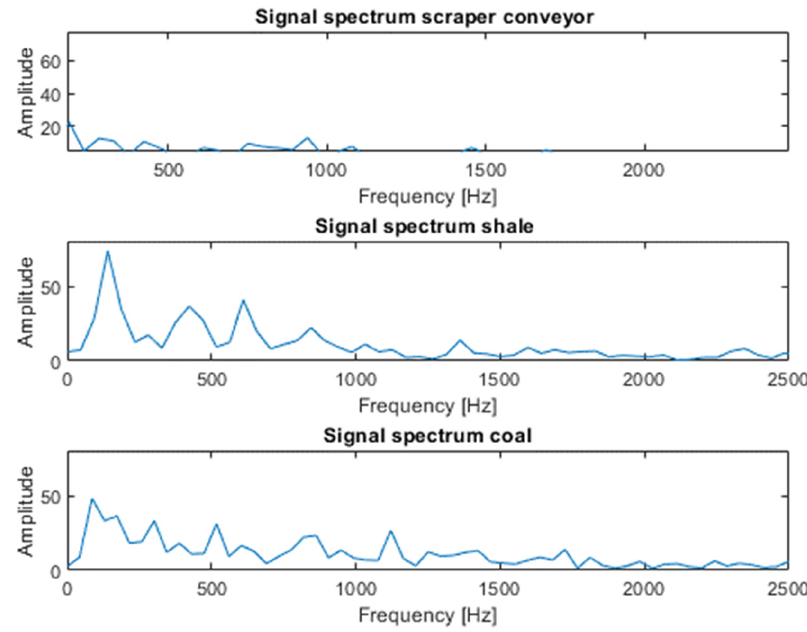
Figure 3. FFT results for the collected sound samples.